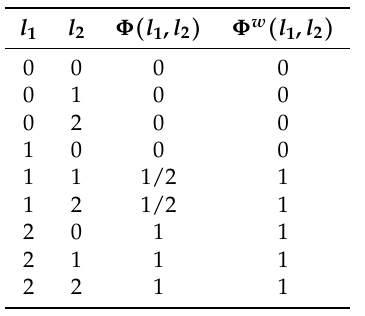
Table 3. Survival signature of the system in Figure 4 with and without